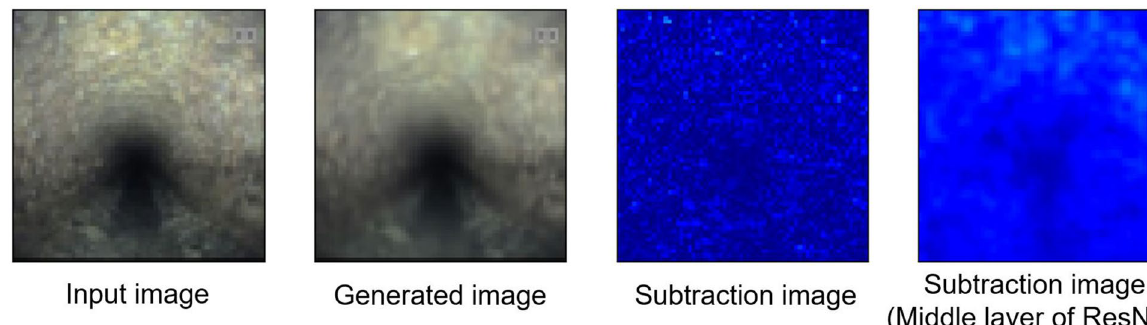
Fig. 10 Experimental results of normal cast iron pipe (VAE)